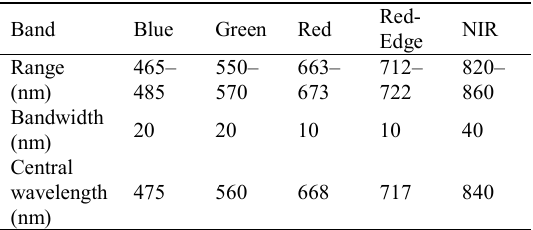
Table 1. MicaSense RedEdge band characteristics